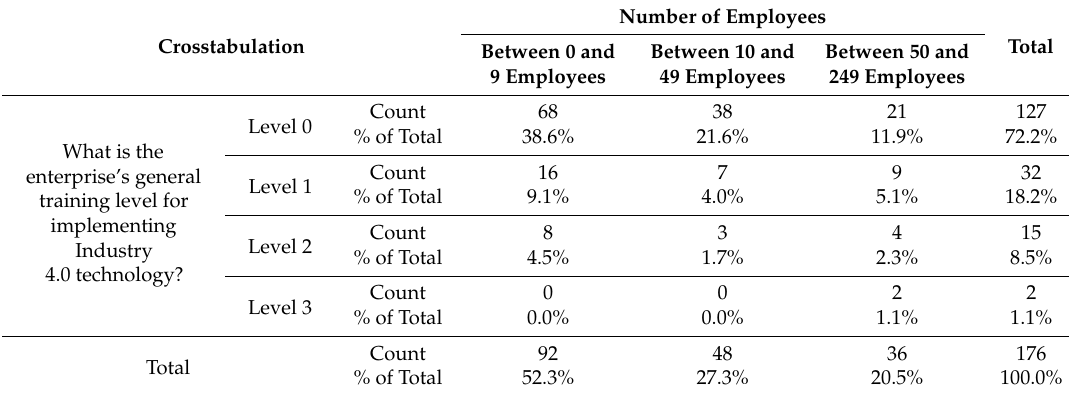
Table 4. The contingency table regarding the training level of SMEs in relation to the size of enterprises.